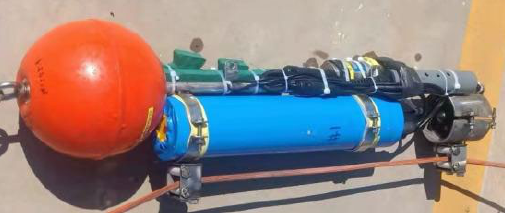
Figure 6. Profile AUV .